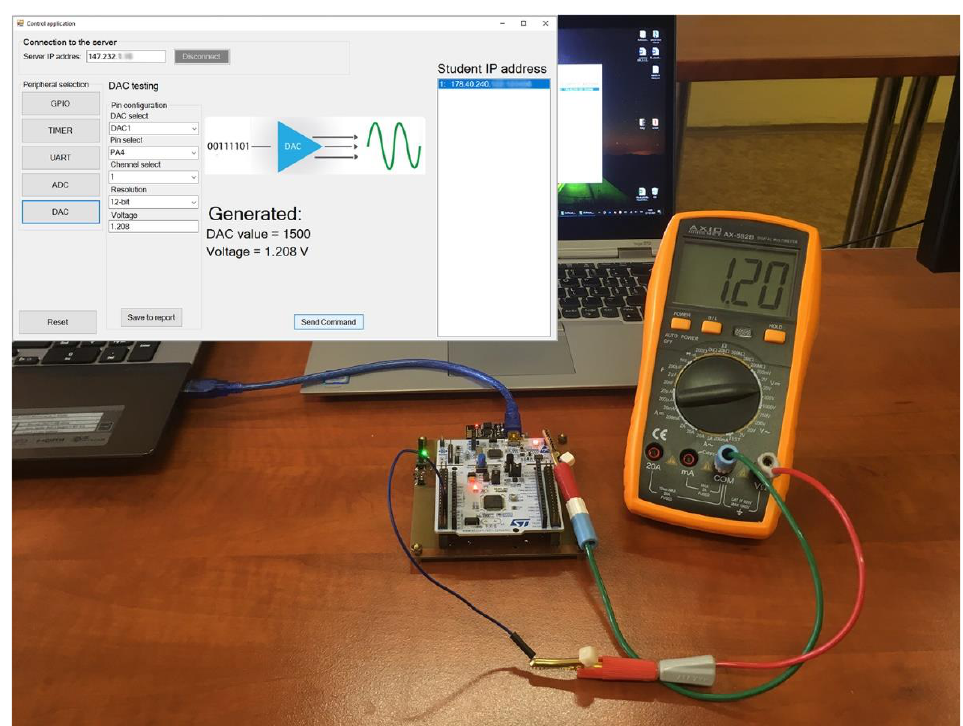
Figure 14. DAC testing with 12-bit DAC1, channel 1 generated through PA4 pin.